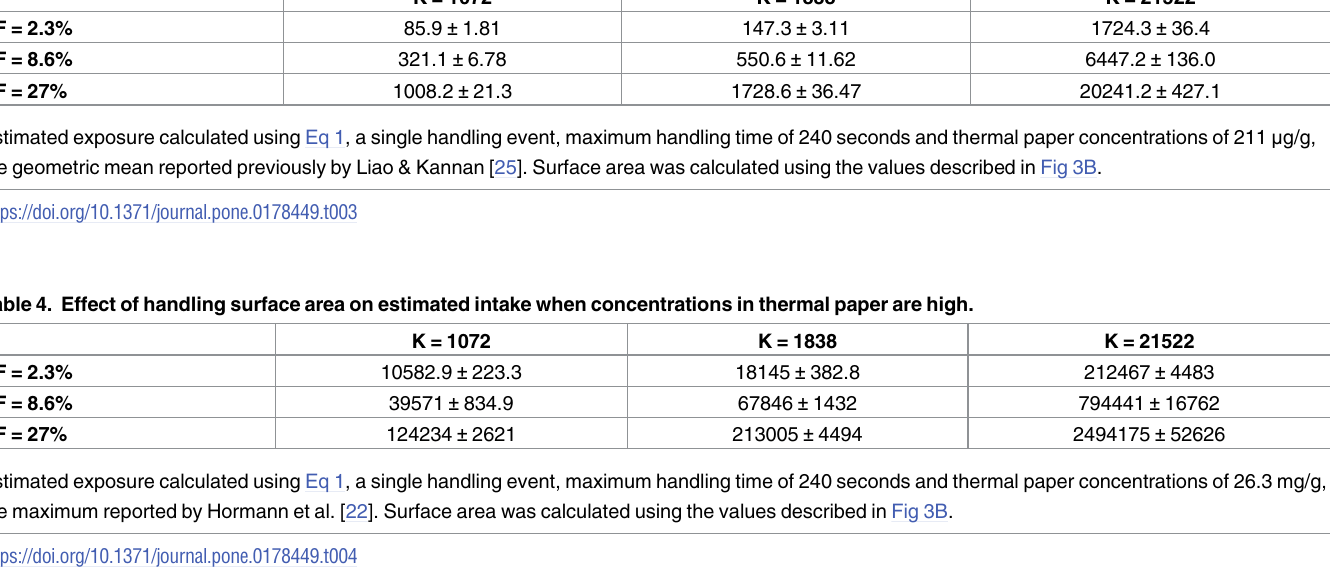
Table 3. Effect of handling surfacearea on estimated intake when concentrations in thermal paper are low. K = 1072